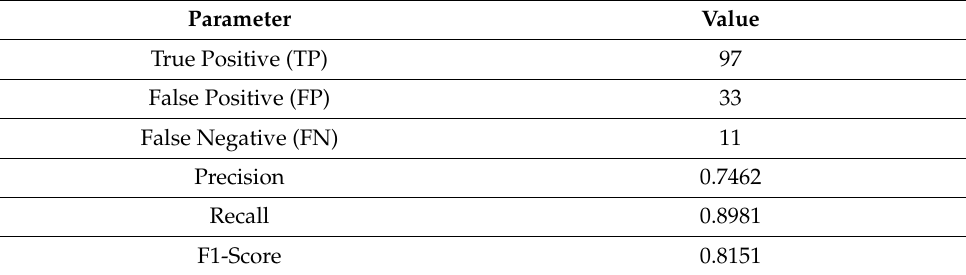
Table 1. The performance of the baseline model (YOLOv4) on the test set.